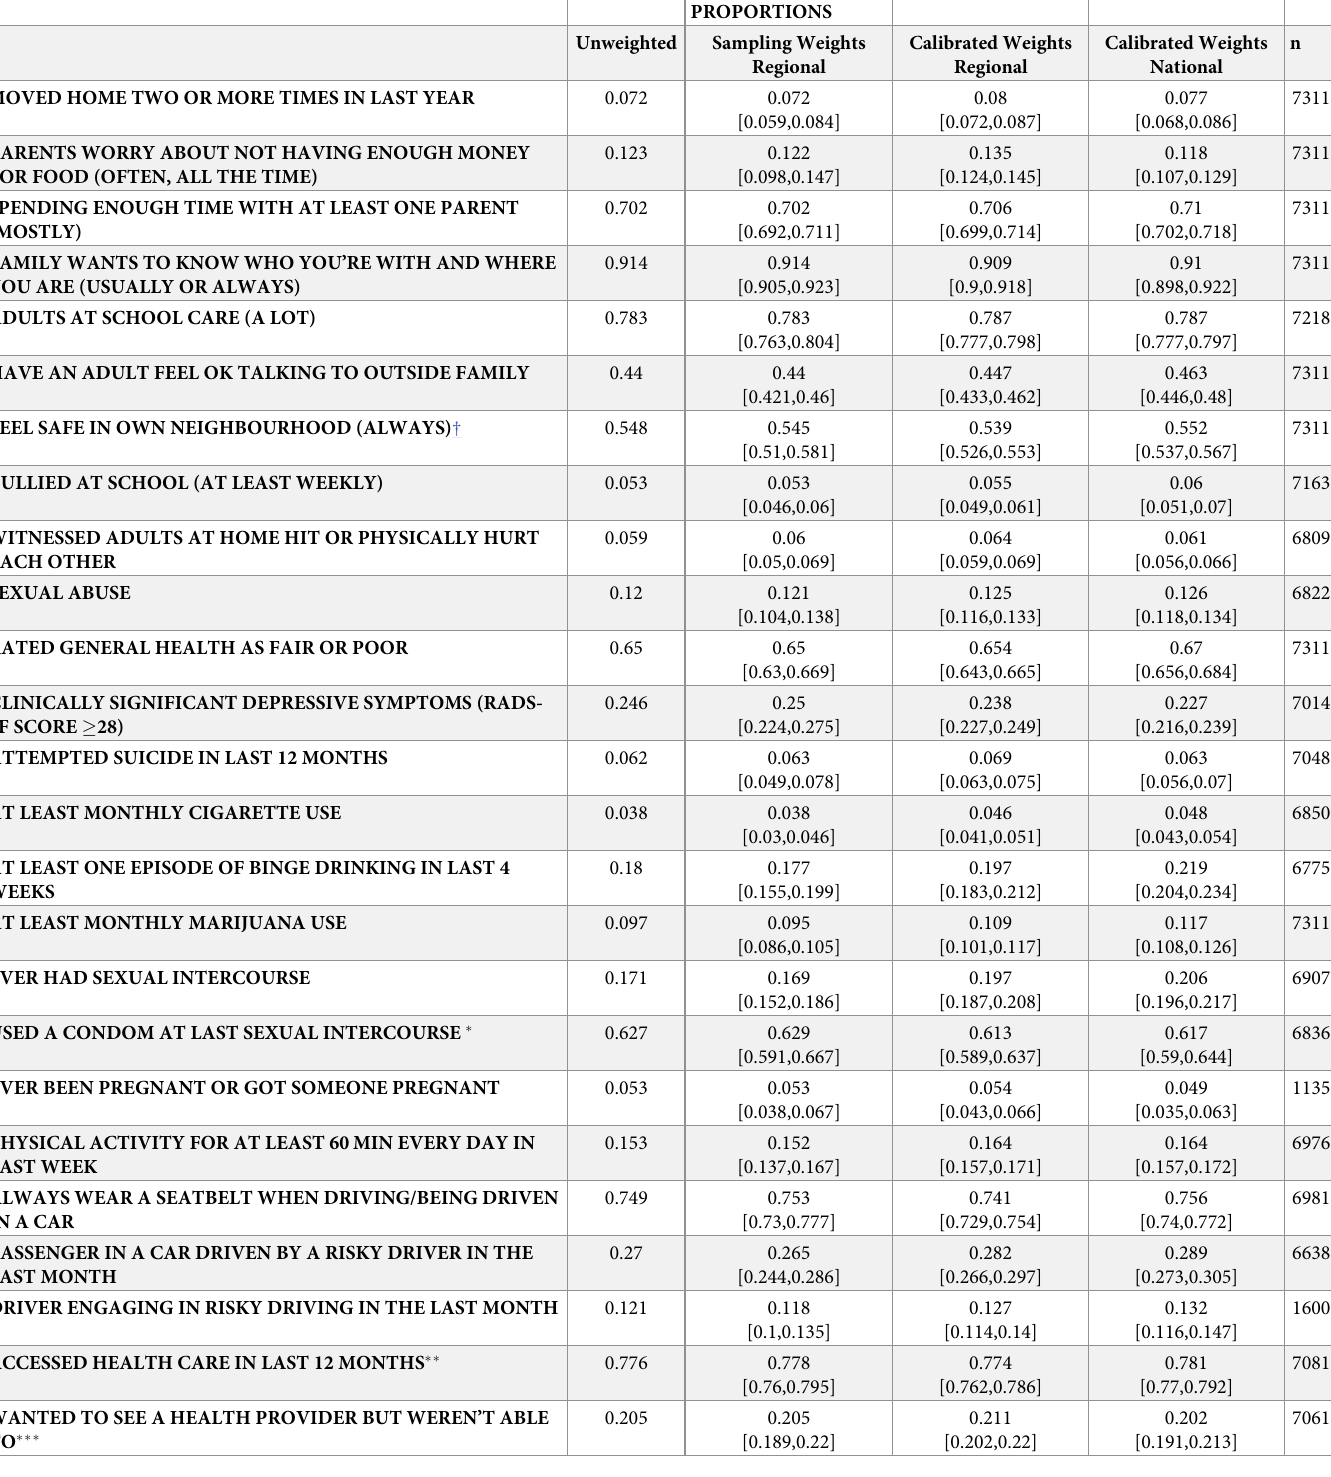
Table 6. Health and wellbeing